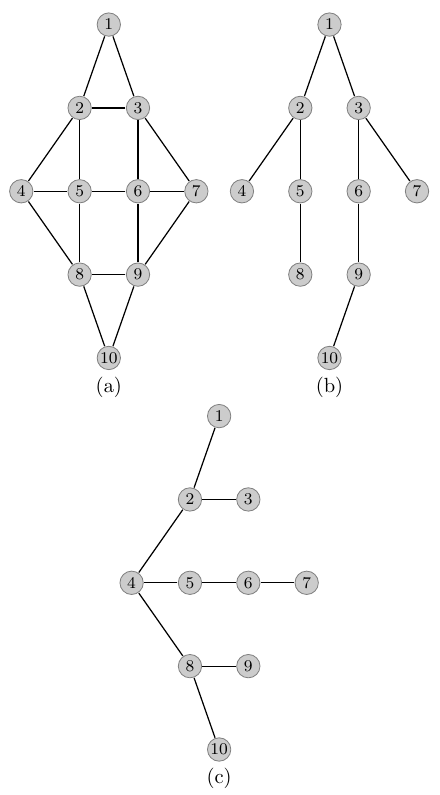
Fig. 1. (a) Graph G ; (b) Spanning tree x ; (c) Spanning tree x (cid:48)